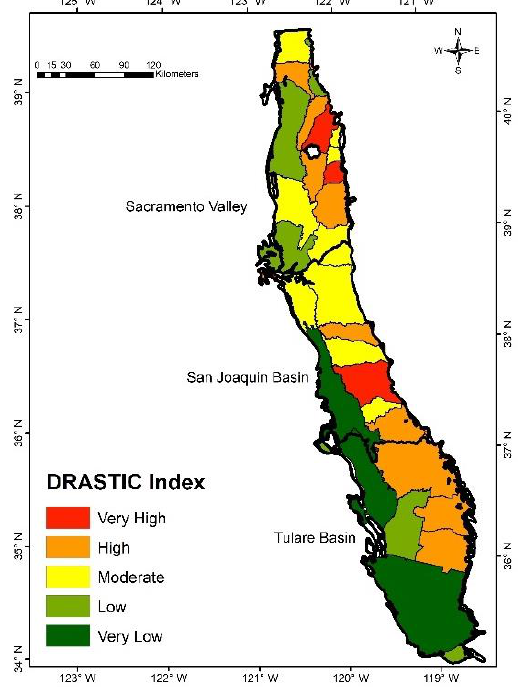
Figure 10. Hydraulic Conductivity in Central Valley.